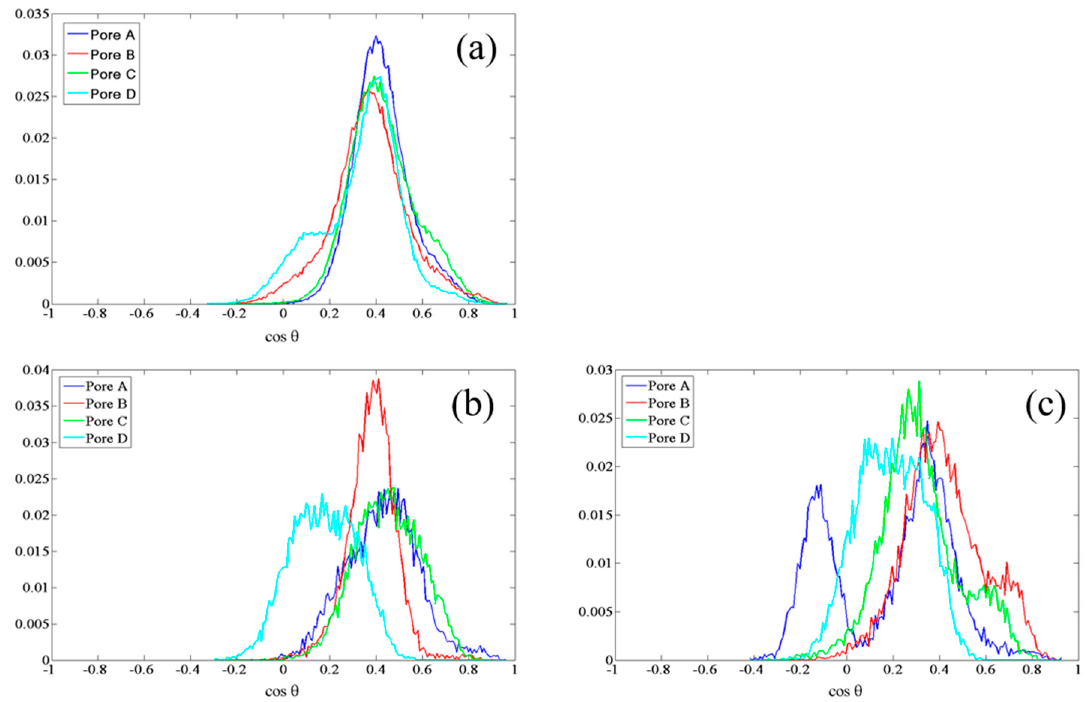
Figure 3. Cont. Figure 3.